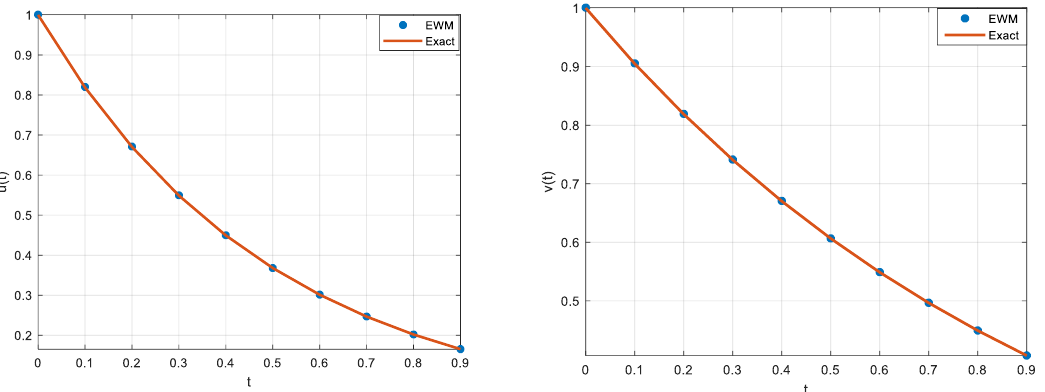
( ) v t () u t and for 1  = , 1 = for Example 2 (